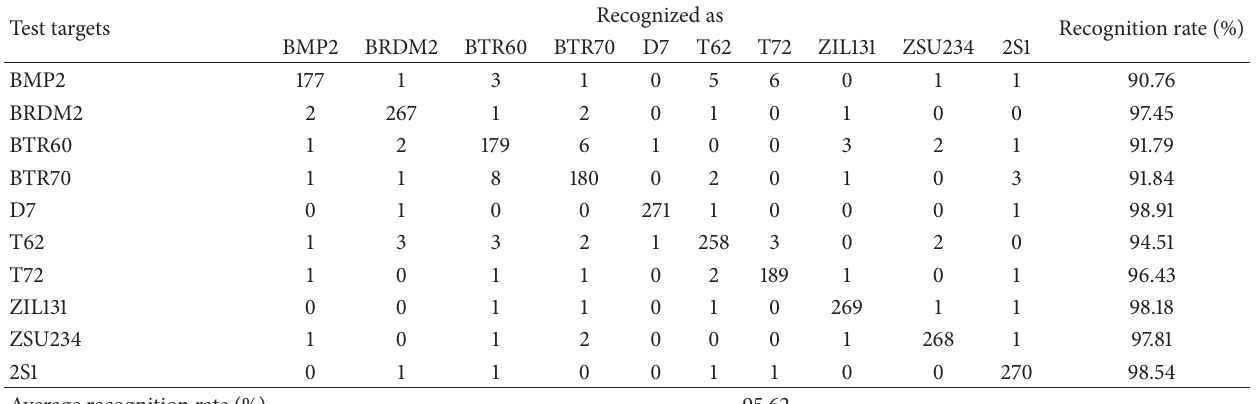
Table 2: Confusion matrix for 10-target classification (6 ∘